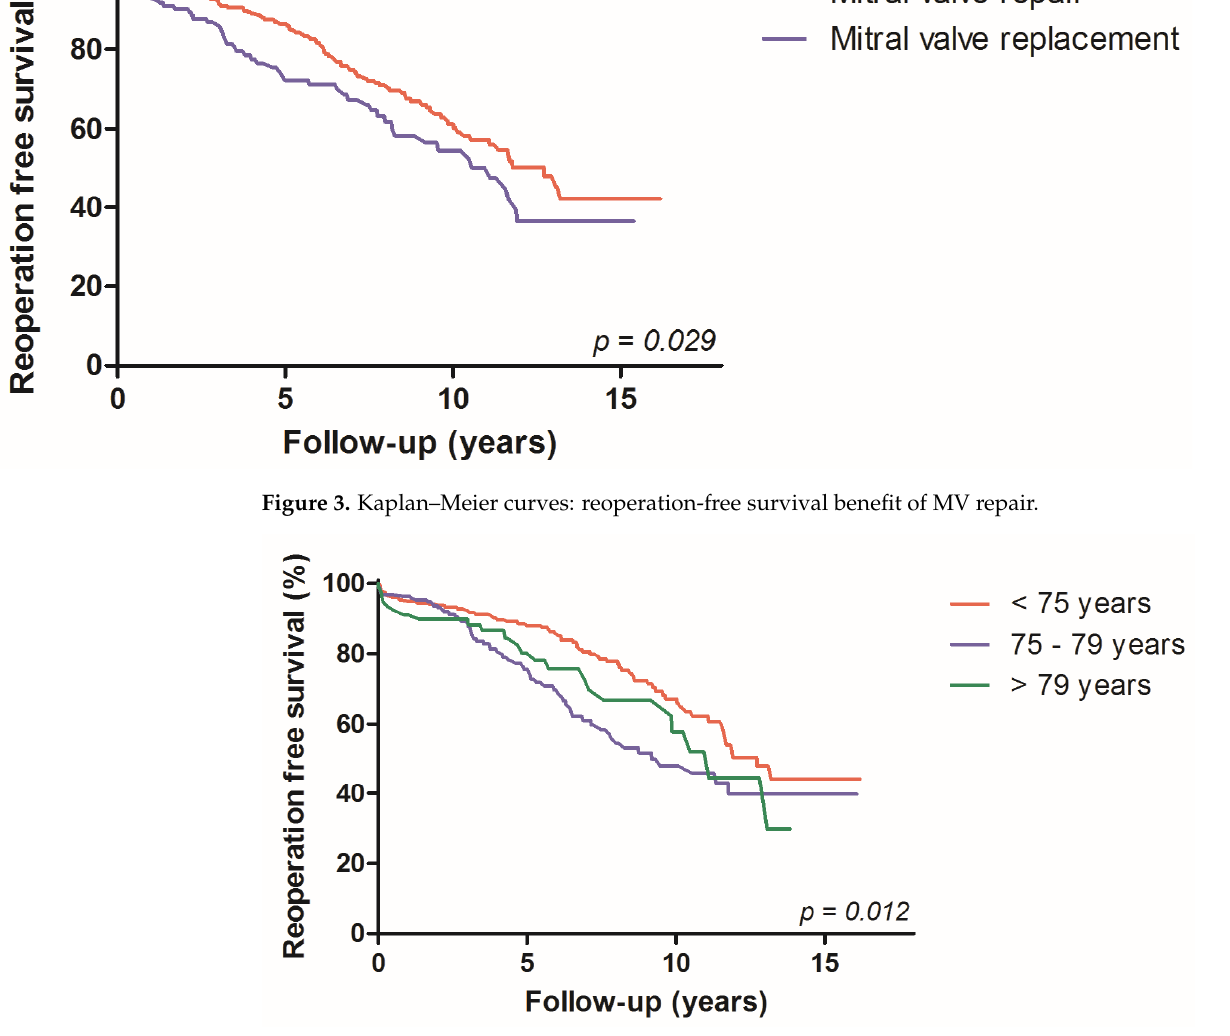
Figure 3. Kaplan–Meier curves: reoperation-free survival benefit of MV repair.